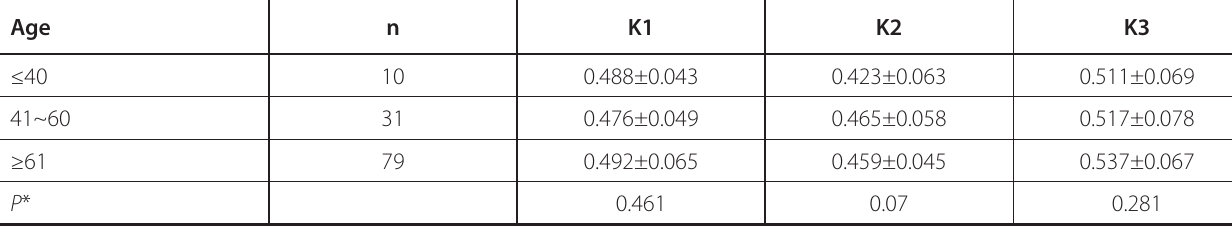
Table 3 . Comparison of K between age groups.